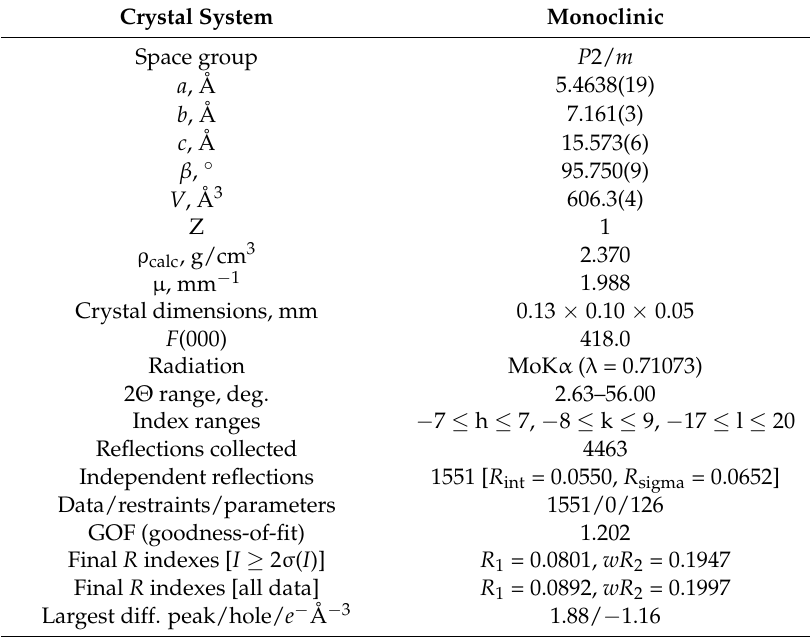
Table 2. Crystal data and structure refinement for shkatulkalite.